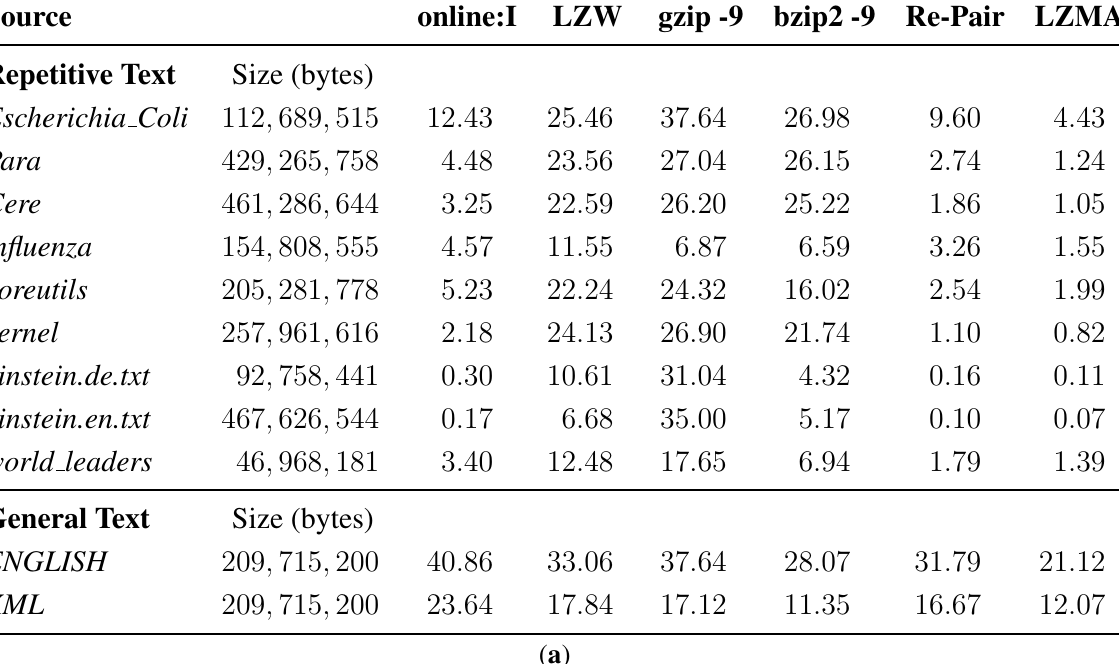
Table 2. Experimental results for LCA-online versus standard